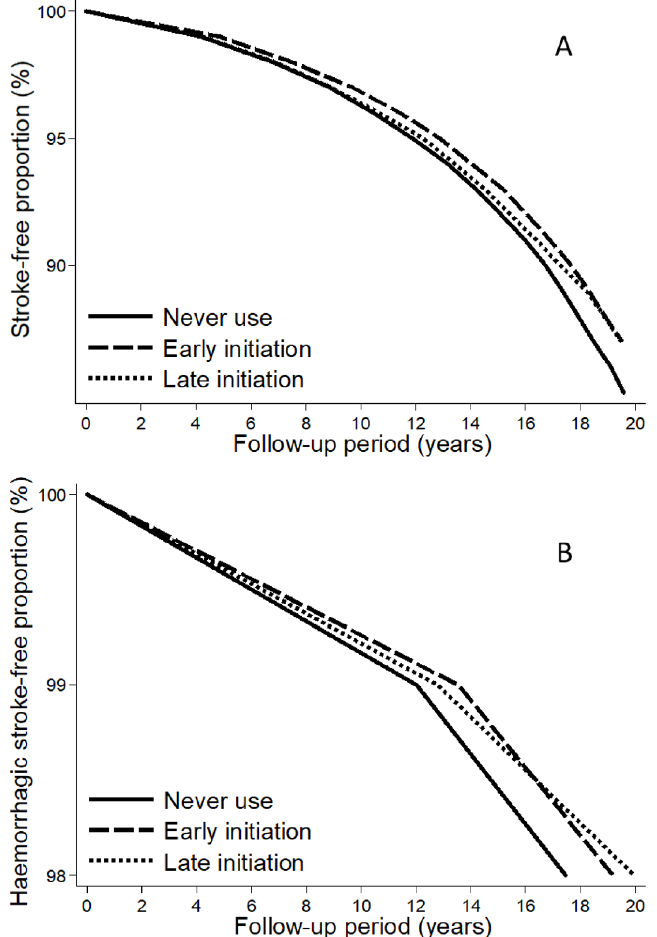
Fig 2. Stroke (A) and haemorrhagic stroke (B) survival curves for early or late initiation, using the 5-yearcutoff, of postmenopausal hormone therapy and never use. The curves were computedusing censoredquantileregression adjusted for age at baseline, level of education,smoking status, body mass index, level of physicalactivity, and age at menopause onset. Our finding that HT users had a similar stroke risk compared to never users is in agreement with the results from some observational studies [18], as well as from 2 RCTs: the Heart and Estrogen/Progestin Replacement Study (HERS) [3] and the Women’s Estrogen for Stroke Trial (WEST) [4]. By contrast, the Nurses’ Health Study (NHS) [20] and the Women’s Health Initia- tive (WHI) [21,35] reported an increased risk of stroke, although neither timing of HT initiation nor regimens other than oral CEE therapy were considered. In all these studies—except WEST [4], in which a composite end point of ischaemic stroke and transient ischaemic attack was used —stroke was analysed as a composite end point of ischaemic stroke and haemorrhagic stroke. Our findings on early HT initiation are not in agreement with those reported from a reanal- ysis of the NHS, where a positive association between HT (when initiated within 4 years from menopause onset) and stroke was observed: relative risk (RR) 1.29 (95% CI 1.06–1.58) and 1.22 (95% CI 0.95–1.55) for CEEs used as single and combined HT, respectively [14]. Reanaly- sis of the WHI [13] suggested that stroke risk did not depend on years since menopause at the time of HT initiation, but the results were not definite: HR 2.24 (95% CI 0.92–5.44) and 1.58